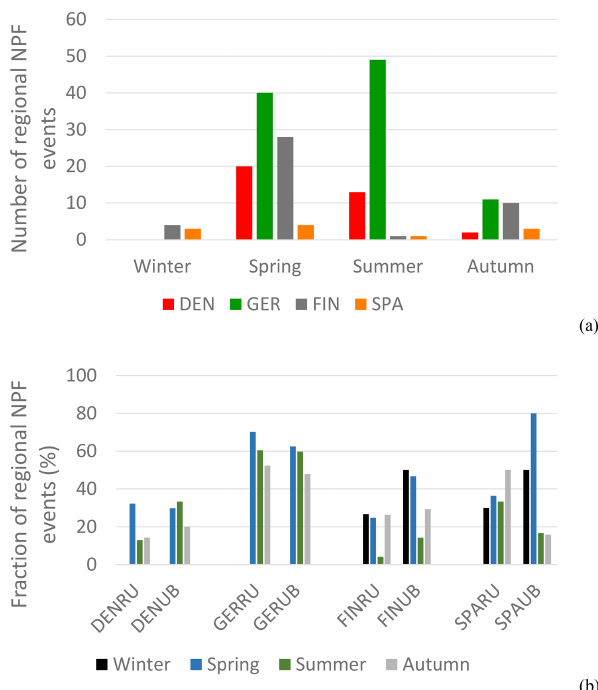
Figure 8. (a) Number of region-wide new particle formation events per season and (b) fraction of region-wide events to total new par- ticle formation events per season for each site. Region-wide events are considered those that occur on the same day at both background sites (rural and urban